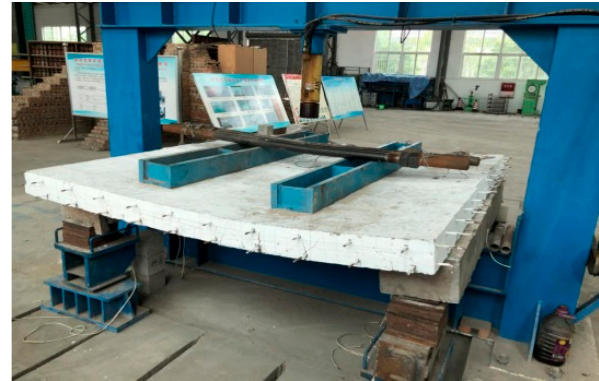
Figure 29. Failure mode of CLHCPCS under ultimate load. The stress and deformation cloud diagrams of CLHCPCS steel grid are shown in Figures 30–34.